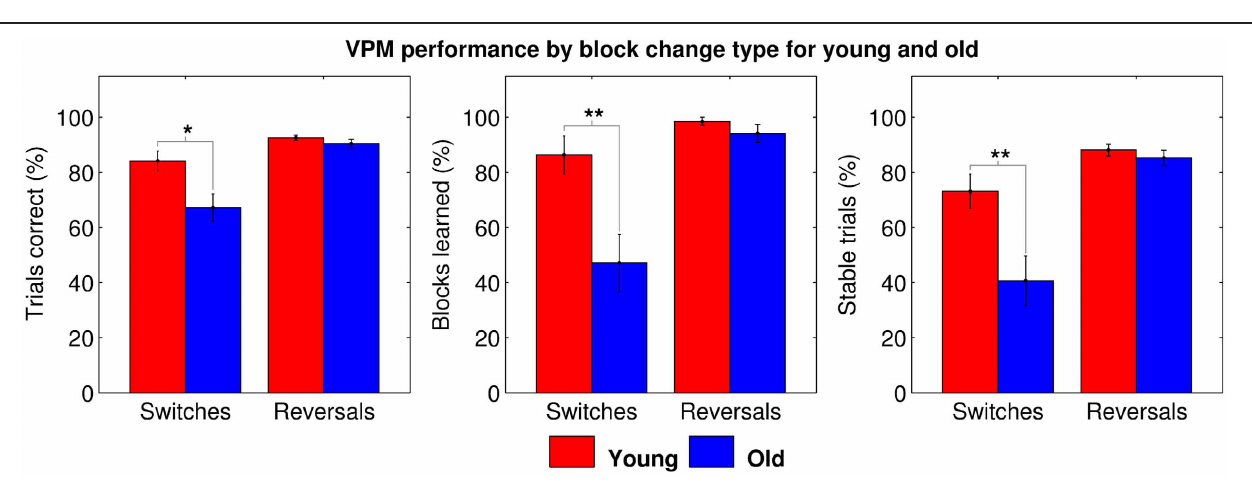
excluding data from first blocks and blocks following unlearned blocks. Significant group differences are indicated at the ∗ 0 . 05, ∗∗ 0 . 01, and ∗∗∗ 0 . 001 levels following Bonferroni